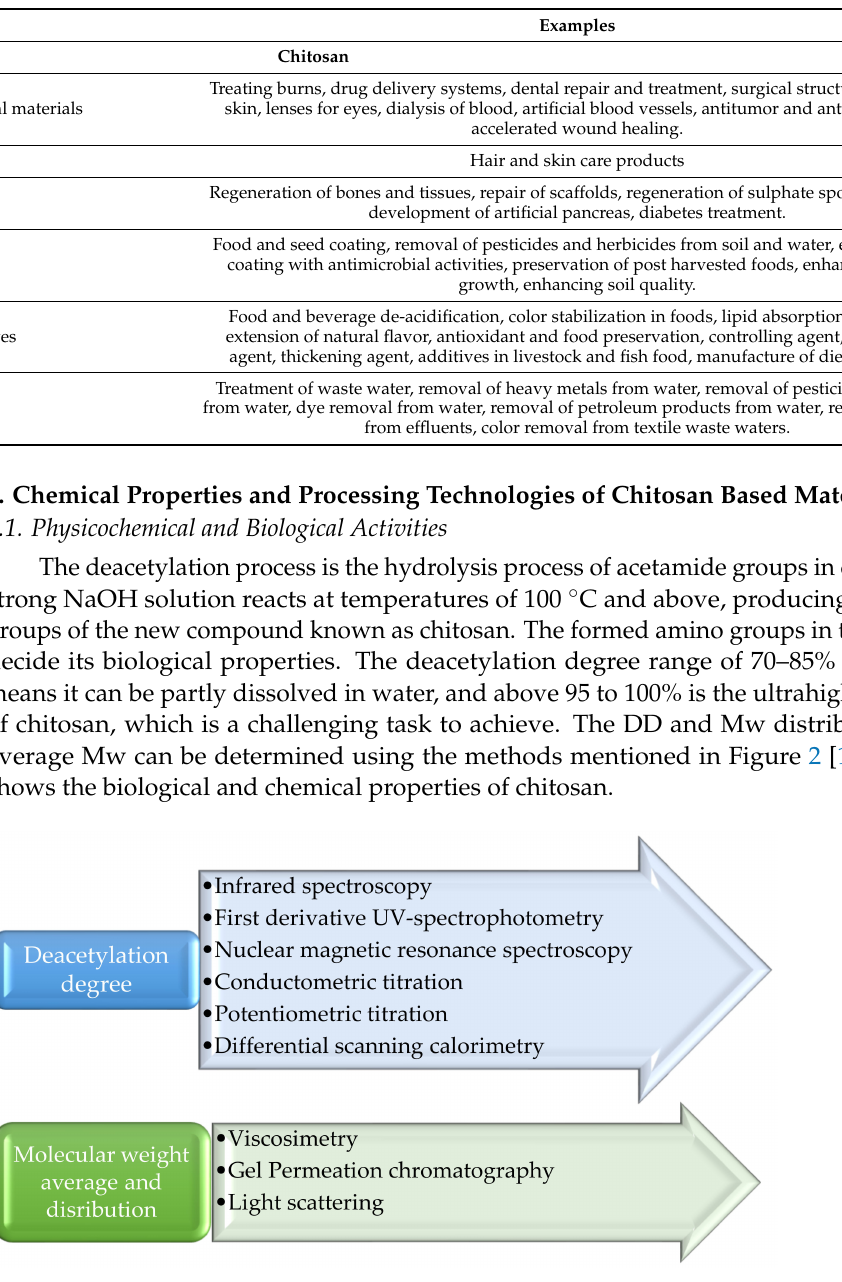
Table 1. Various applications of chitosan [12].